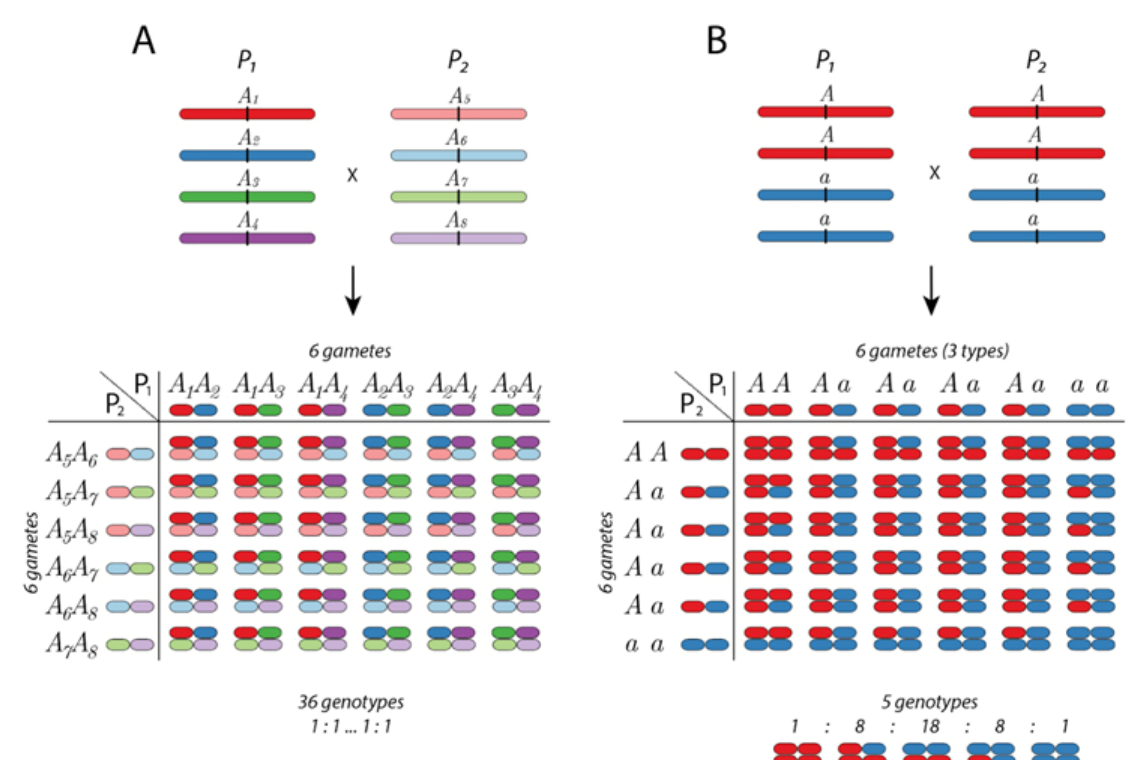
Figure 2. Thirty-six possible genotypes in an autotetraploid cross. ( A ) Completely informative multiallelic scenario, in which all the genotypes formed by the combination of 6 gametes can be differentiated and segregated with equal probability. ( B ) Biallelic scenario, in which both parents have two doses (duplex marker), in which case the genotypes collapse into five different classes segregating in a 1:8:18:8:1 ratio.